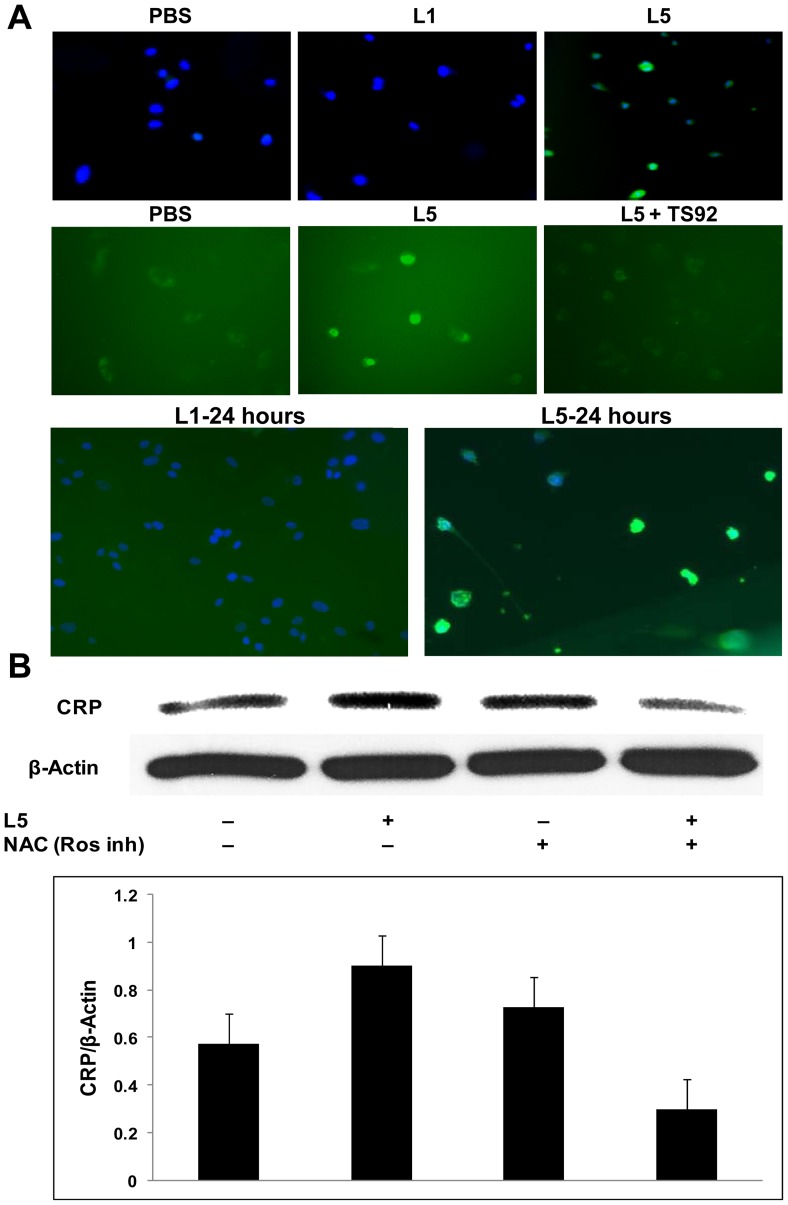
Detection of total reactive oxygen species (ROS) in human aortic endothelial cells (HAECs).(A) L5 (50 µg/mL) from patients increased ROS production (green) in HAECs after 20 minutes (top and middle row) and after 24 hours (bottom row). Compared to the phosphate-buffered saline (PBS) control, L1 treatment had no effect. Staining with 4′,6-diamidino-2-phenylindole (DAPI) (blue) indicated HAEC apoptosis 24 hours after L5 (50 µg/mL) exposure. The pretreatment of cells with TS92 attenuated the L5-induced ROS increase after 20 minutes (middle row). (B) Blocking the production of ROS by adding ROS inhibitor N-acetyl cysteine (NAC) attenuated the L5-induced increase in CRP levels. For all experiments, n = 3, and bars shown in graphs represent standard deviation. *P<0.05, **P<0.01 vs. untreated control.